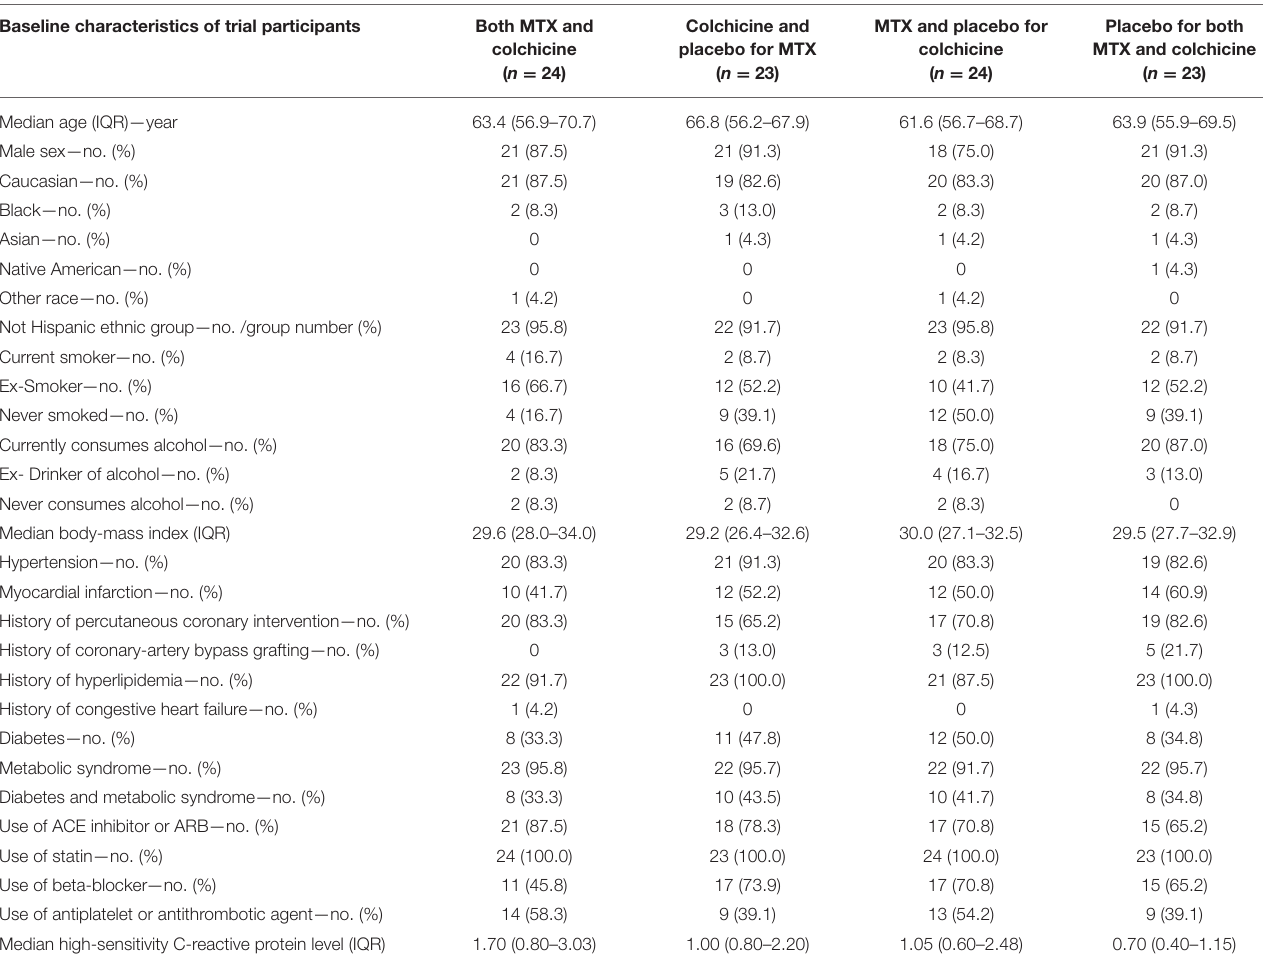
TABLE 1 | Demographic characteristics of trial population. Baseline characteristics of trial